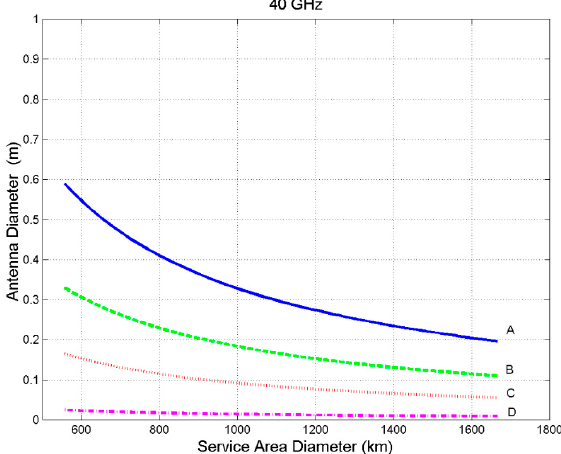
Figure 8. Antenna diameter as a function of the service area diameter, at 40 GHz for the GeoSurf constellation. A refers to h = 35,876 km; B to h = 20,000 km; C to h = 10,000 km, D to h = 1500 km.